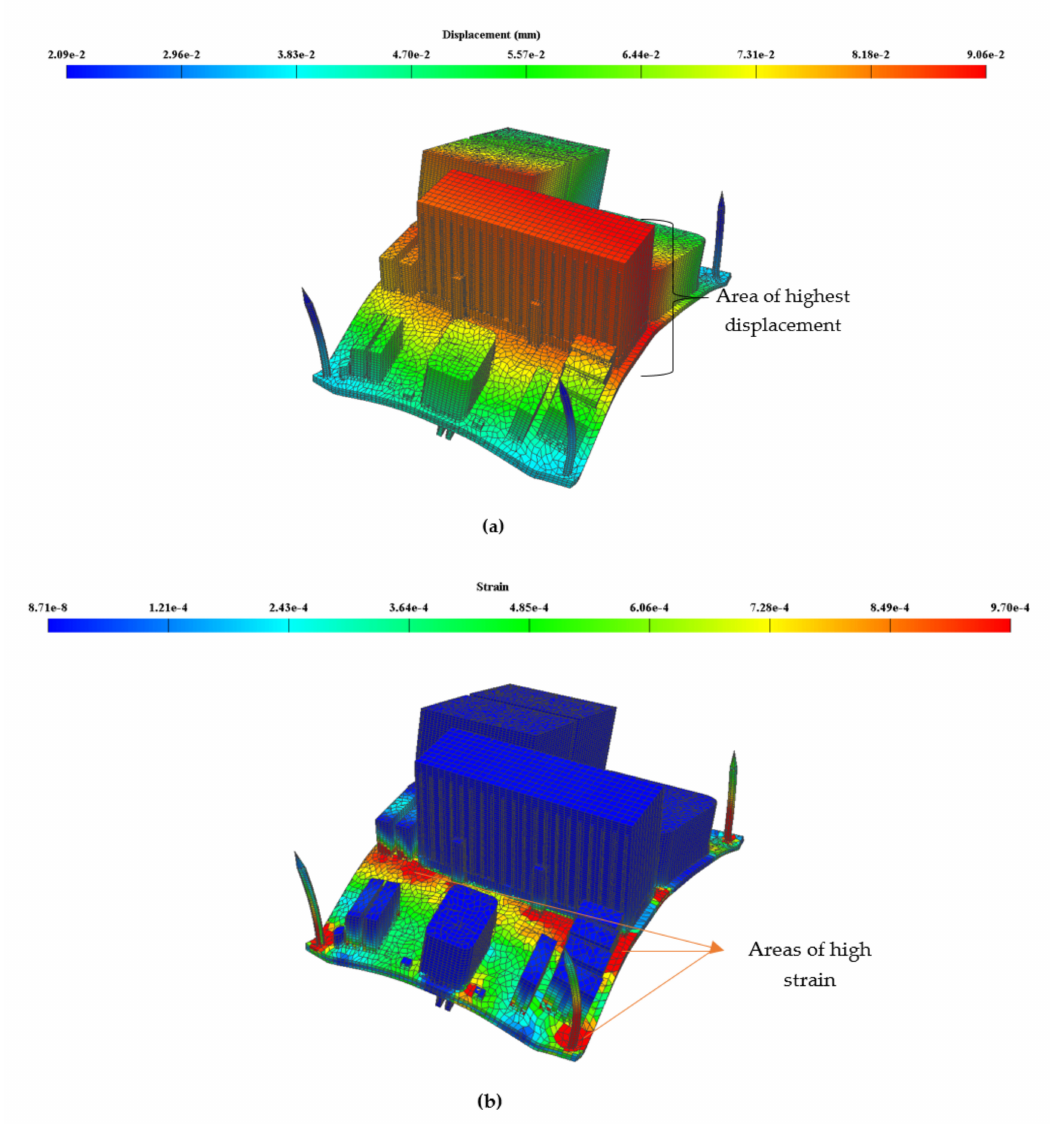
Figure 12. ( a ) Random vibration RMS displacement. ( b ) Random vibration strain RMS